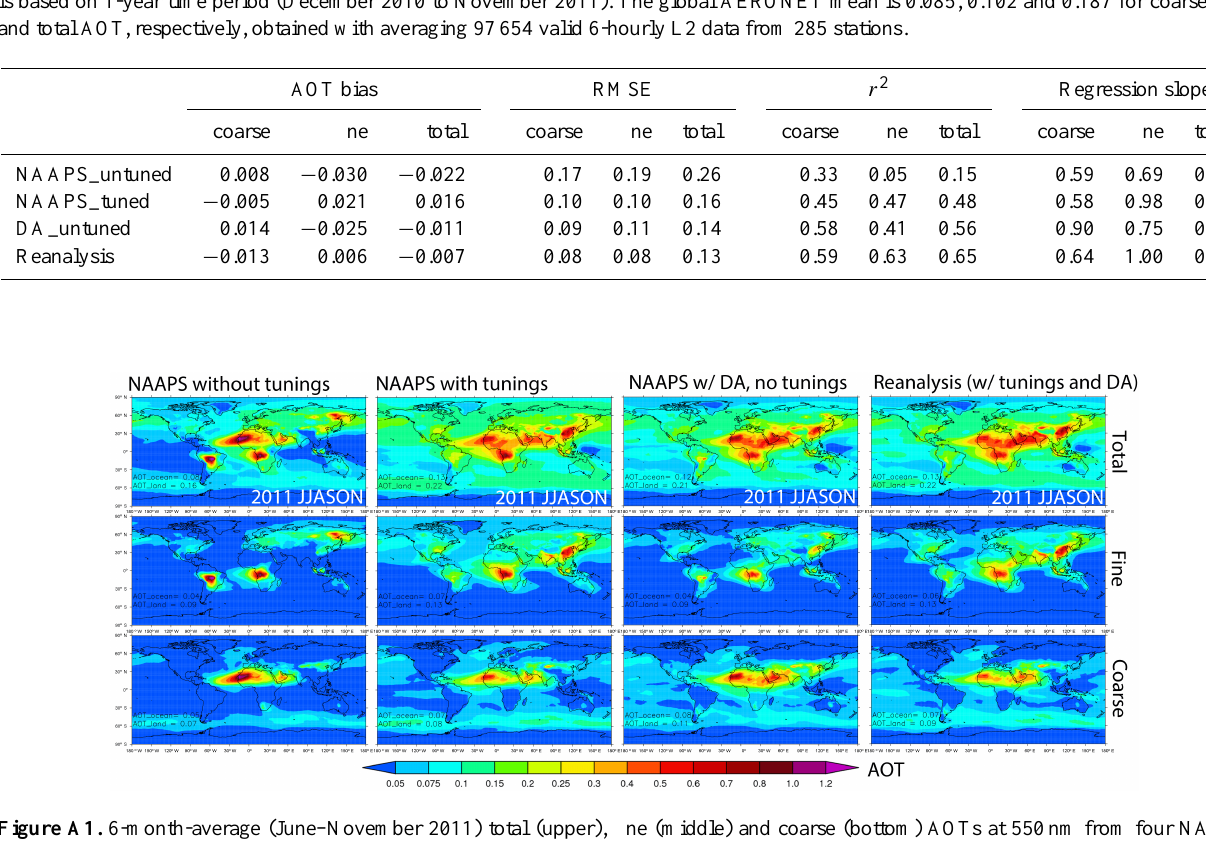
Figure A1. 6-month-average (June–November 2011) total (upper), fine (middle) and coarse (bottom) AOTs at 550nm from four NAAPS runs with different configuration: NAAPS without tuning, NAAPS with tuning processes on sources and sinks, NAAPS without tuning but with AOT data assimilation and the reanalysis version, which is with both tuning and AOT assimilation. Annotations at the bottom left in the figures show the area mean AOTs over ocean and over land averaged for 40 ◦ S–60 ◦ N.